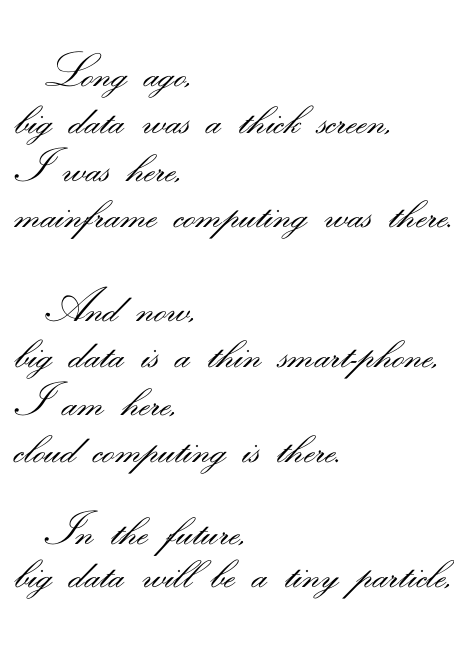
Figure 5 . The Big Data Poem in